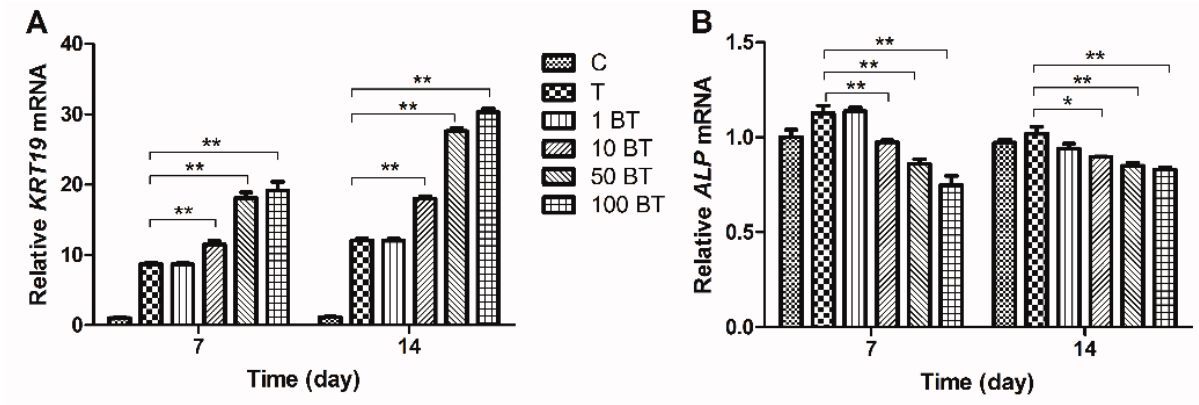
Figure 5. Expressions of differentiation related gene markers of MSCs treated with 10 ng/mL TGF- β and different gradients of BMP3 on days 7 and 14. Expression of novel NP markers ( A ) KRT19 , and characteristic markers of osteocytes ( B ) ALP ; ( C ) OPN and ( D ) COMP were normalized to 18S and to the day 7 control group. Data represent mean ± SD; * p < 0.05, ** p <